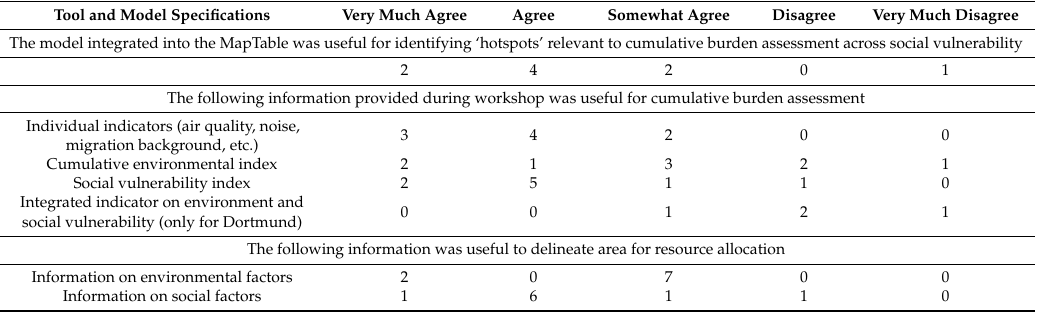
Table 1. Evaluation of participants’ responses on usefulness of the tool and model specifications. Tool and Model